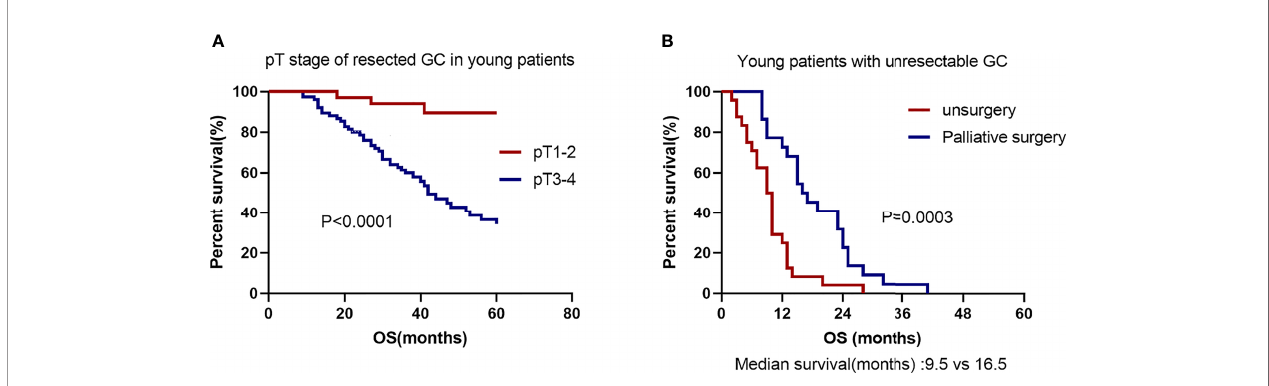
FIGURE 3 | Kaplan – Meier GC survival curve based on signi fi cant prognostic predictors for overall survival in EOGC patients with resectability and unresectability. (A) pT stage of resectability GC in EOGC patients. (B) No surgery or palliative surgery in EOGC patients with unresectable GC.